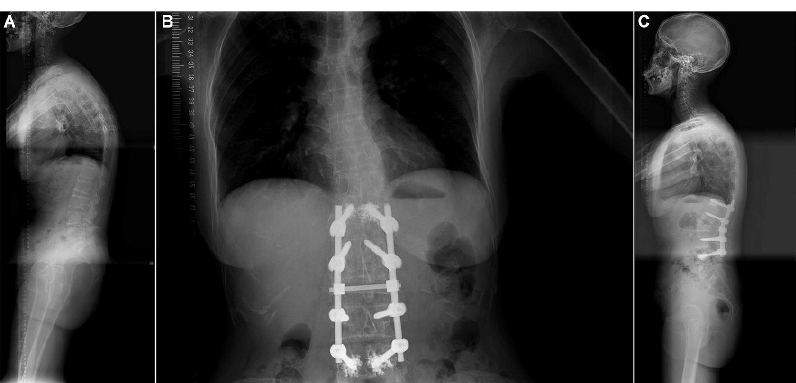
Figure 3 - A: A 43-year-old female patient who had a 10-year history of lower back pain and kyphosis. The pain had been worsening for 1 year and she was diagnosed with ankylosing spondylitis and kyphosis. B and C: The patient underwent a partial osteotomy of the key vertebrae without intervertebral fusion. CICPS augmentation with PMMA was used at the top and bottom of the internal fixation instrument. X-ray images showed good spinal correction 6 months after the surgery.